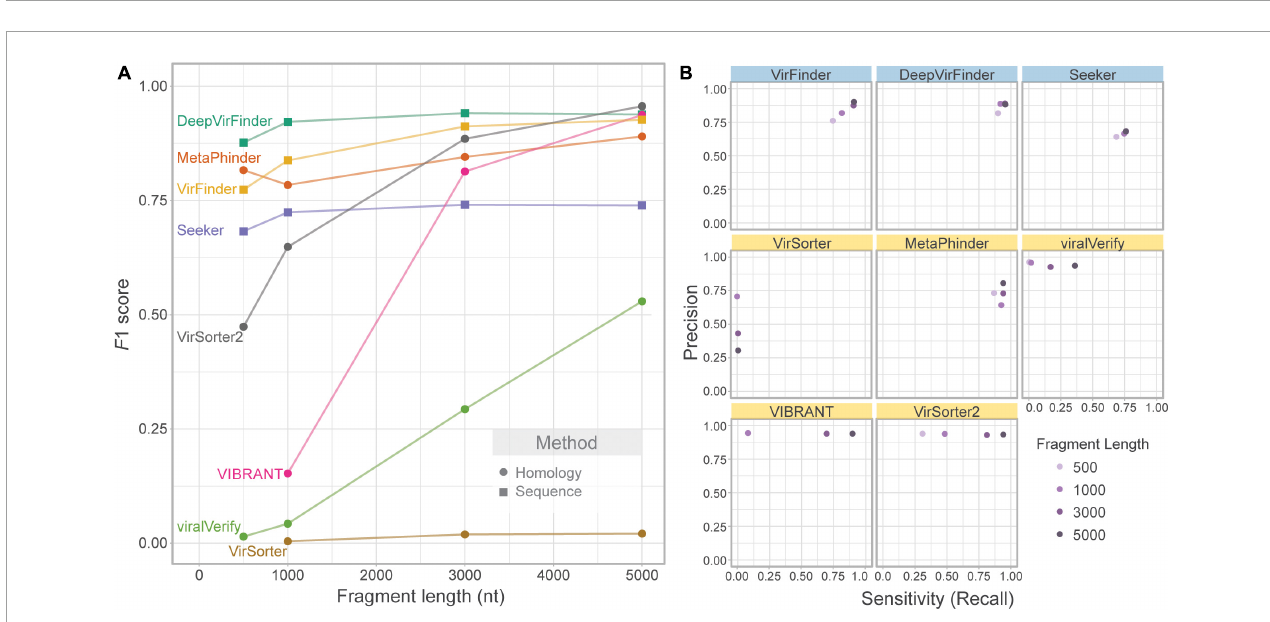
FIGURE2 Effect of fragment length on classification performance. Only phage and bacterial sequence fragments are included. (A) Balanced F 1 score plotted against fragment length (nt) and (B) balanced precision plotted against sensitivity for four fragment lengths. Top row of tools are sequence-based (in blue), bottom two rows are homology-based (in